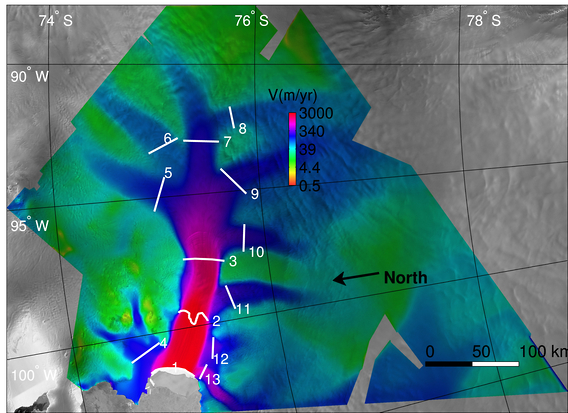
Figure 5. Fluxgates used to compute mass fluxes on tributaries of the PIG. Each gate is numbered from 1 to 13 and corresponds to one tributary. Gate 1 coincides with the ice front, and gate 2 coincides with the 1996 grounding line. The gates are superimposed on an In- SAR surface velocity map of the area, in logarithmic scale (Rignot, 2008). Image is taken from Larour et al. (2012b), courtesy of the Journal of Geophysical Research: Earth Surface